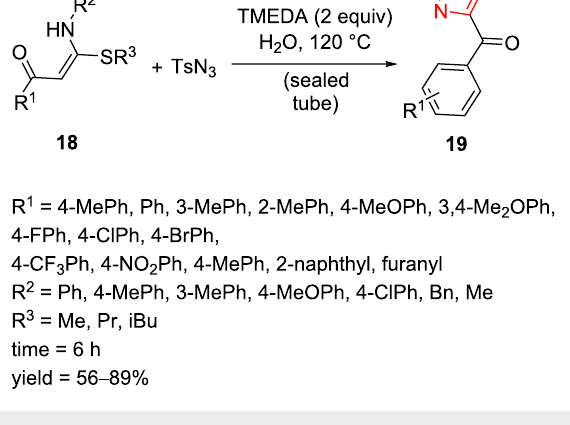
desired fully substituted triazoles in good to high yield. The to give the corresponding products in good to excellent